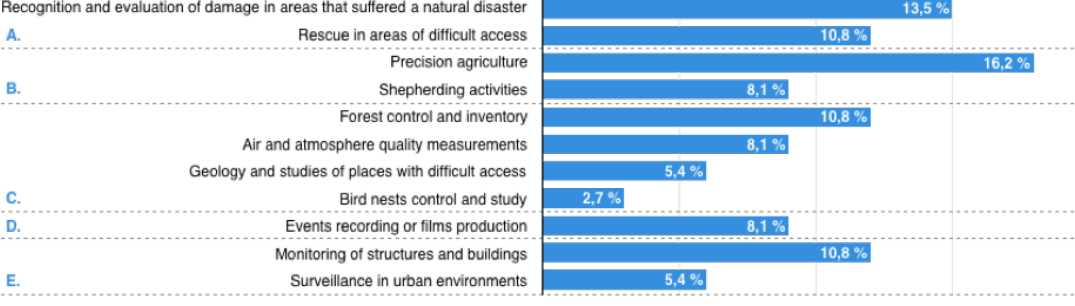
Figure 2. Categories identified and the number of case